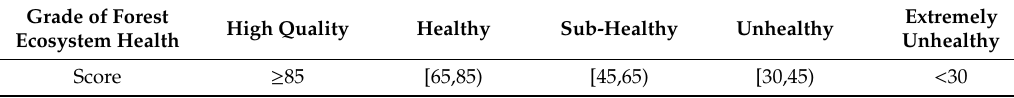
Table 7. Grading of forest level.